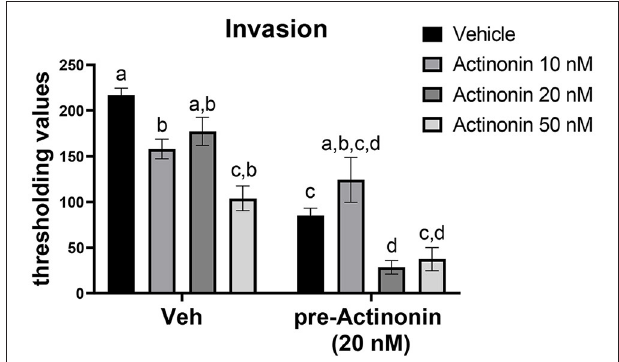
FIGURE 4 | Blocking matrix metalloproteinases inhibits the invasion of mEmLe cells in vitro . mEmLe cell invasion through Matrigel (0.5mg/ml) with vehicle (Veh) and actinonin treatment (10, 20, 50nM) or 16 h pretreatment with actinonin (50nM). Cells were allowed to invade for 16 h. Letters different than each other are statistically significant, p < 0.05, One-way ANOVA, Welsh’s correction, Dunnett’s T3 multi-comparison